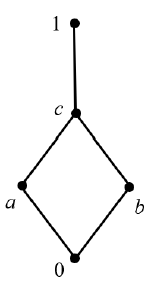
Figure 5. Lattice structure of (2) in Example